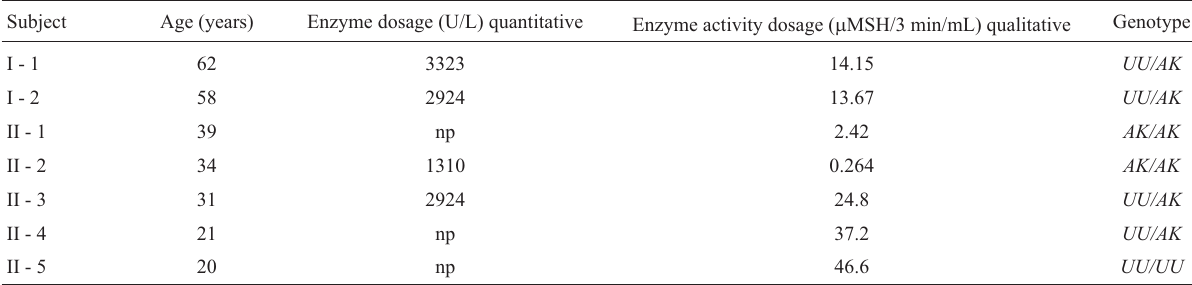
Table 1 - BChE enzyme dosage and activity in the patient (II.2) and her